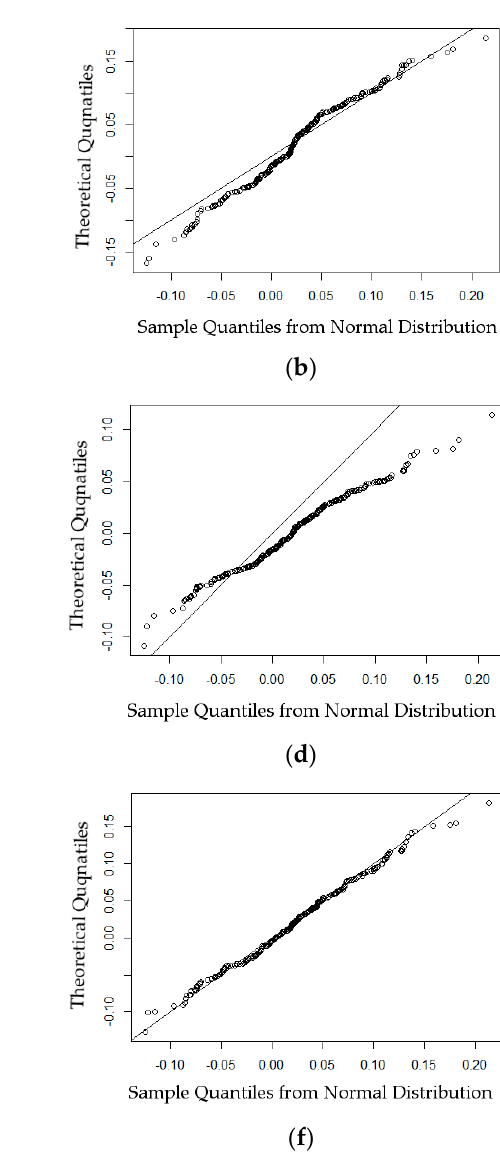
Figure B1. Histograms of distributions of coordinate differences of ( a ) Δ𝑁 and ( c ) Δ𝐸 and ( e ) height differences Δℎ . The blue line marks the expected number of deviations in the case of normal distribution of deviations with an estimated mean value and the standard deviation of coordinate differences. The Q–Q plot of coordinate differences at ( b ) Δ𝑁 and ( d ) Δ𝐸 and ( f ) height differences at the points Δℎ present quantiles of individual differences. The line shows theoretical quantiles of the normal distribution.